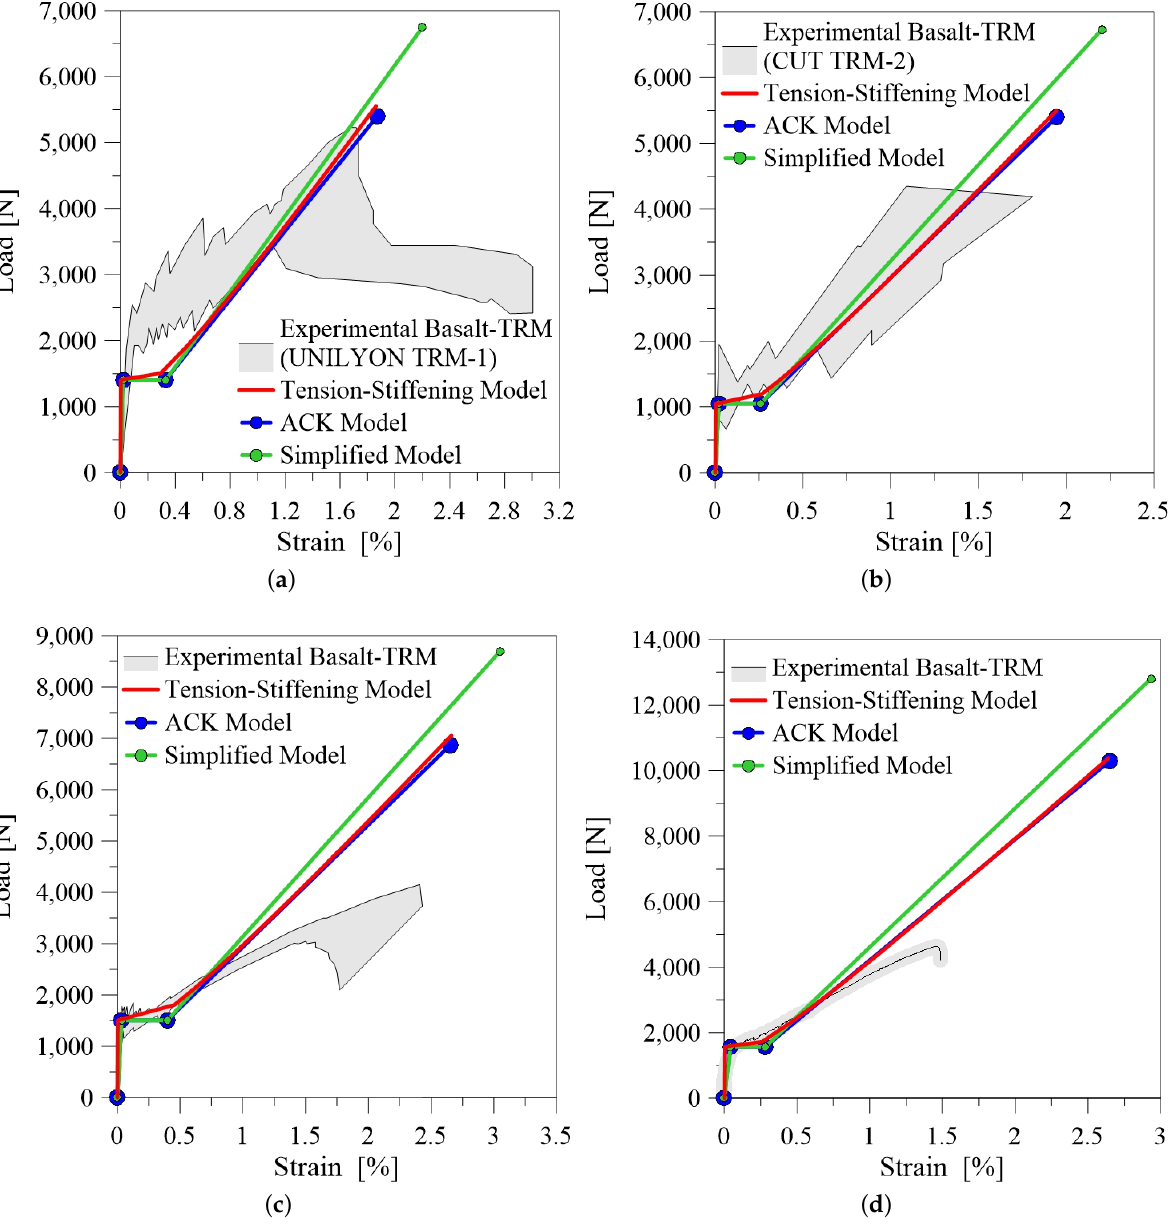
Figure 6. Comparison between experimental and analytical curves for basalt-TRM: ( a ) reference Lignola et al. [21] (Fabric Reinforced Cementitious Matrix (FRCM) 1 UNILYON); ( b ) reference Lignola et al. [21] (FRCM 2 CUT); ( c ) reference D’Anna et al. [24] (2L); ( d ) reference D’Anna et al. [24]